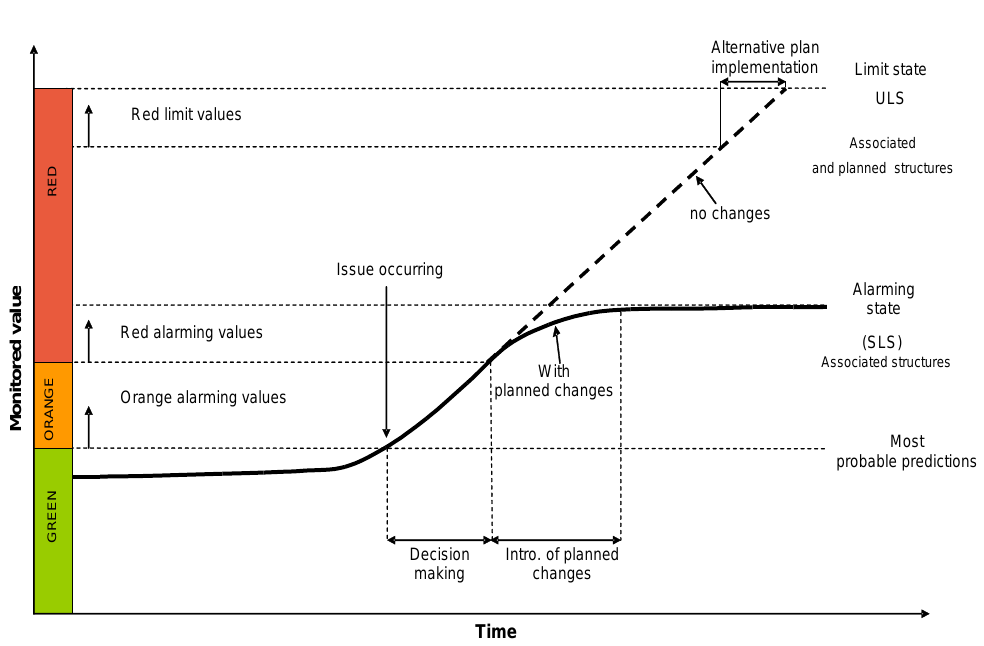
Figure 4. Observational method approach used in the present study.